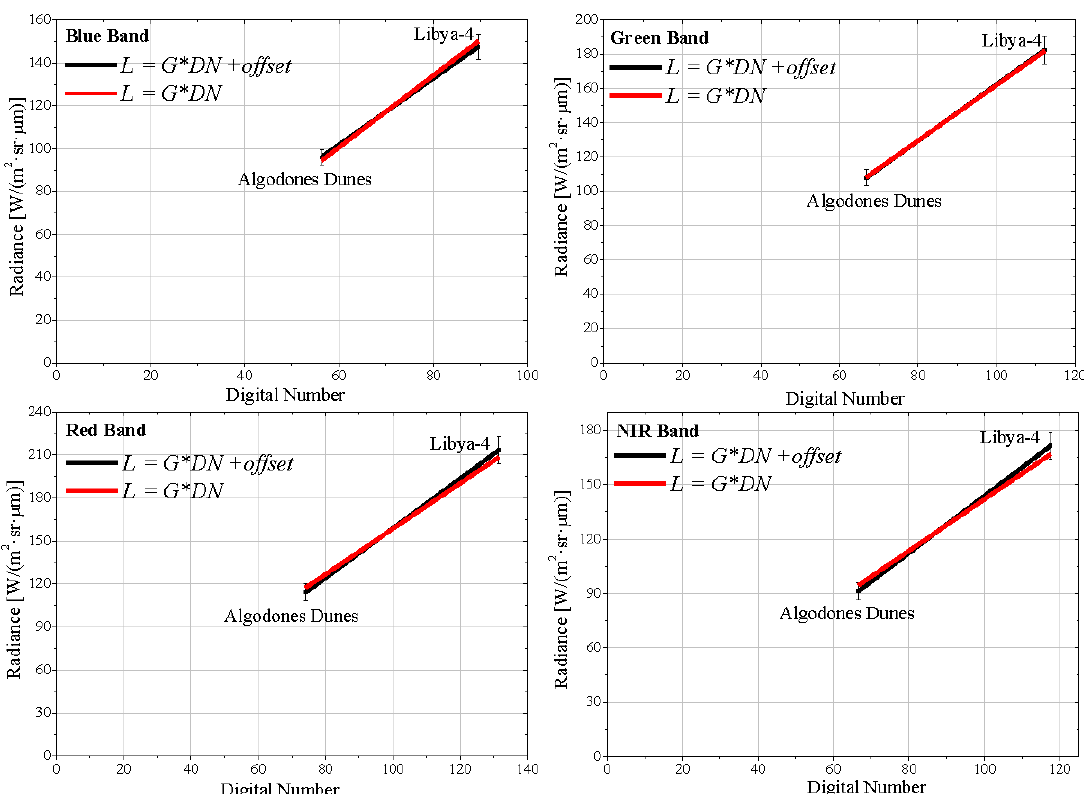
Figure 9. Absolute radiometric calibration of MUX/CBERS-4.